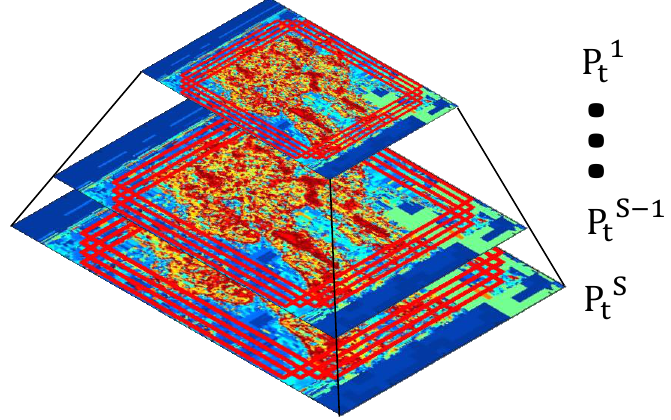
Figure 5. Visualization of anchors region based on feature pyramid. Red rectangles represent anchors at different aspect